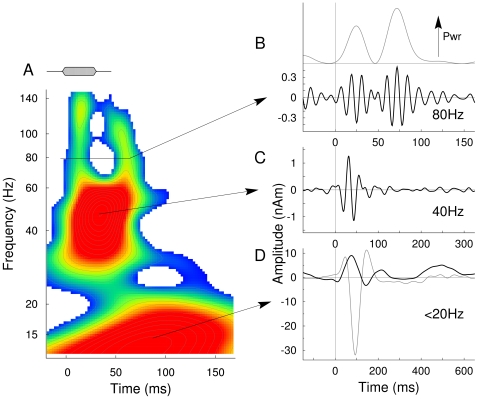
Overview of the types of auditory evoked responses.
A: The time-frequency map of inter-trial coherence in the responses to the 34-ms no-gap stimulus shows three main effects: the low frequency response below 20 Hz, the transient gamma band response at 40 Hz, and high-gamma responses at 80 Hz and above. B: The time series of activity in the high-gamma band shows two bursts of oscillations, which are expressed in two peaks in the time series of the signal power (upper trace). C: The transient 40-Hz response is likely equivalent to the middle-latency response. D: The low frequency response (black) shows predominantly a positive peak resembling a P1m response. The N1m -P2m response is strongly reduced because of fast stimulus repetition. For comparison the response to same stimuli at longer SOA (1500ms) is shown as gray line.